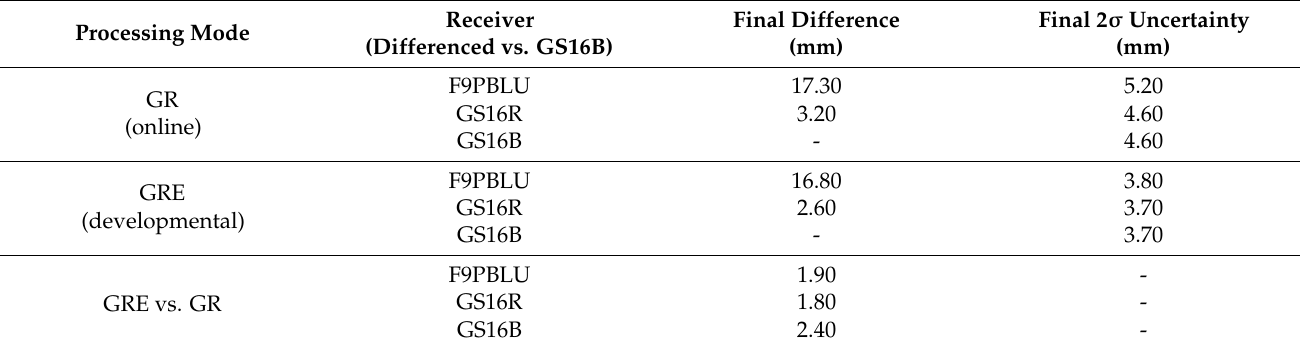
Table 2. Static dataset A height final differences and 2 σ